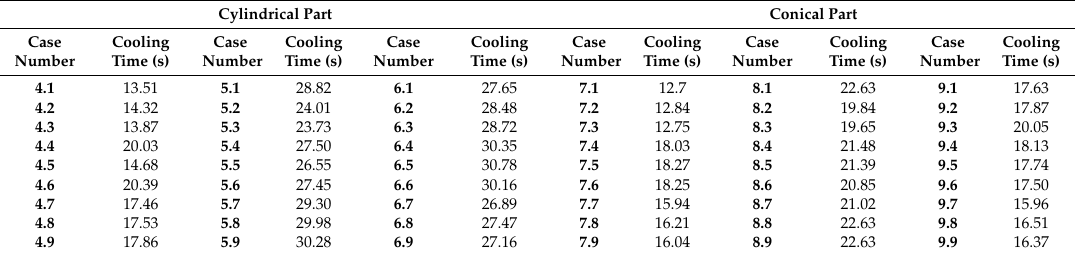
Table 9. Thermal analysis results (cooling times) for DOE 4, 5, 6, 7, 8 and